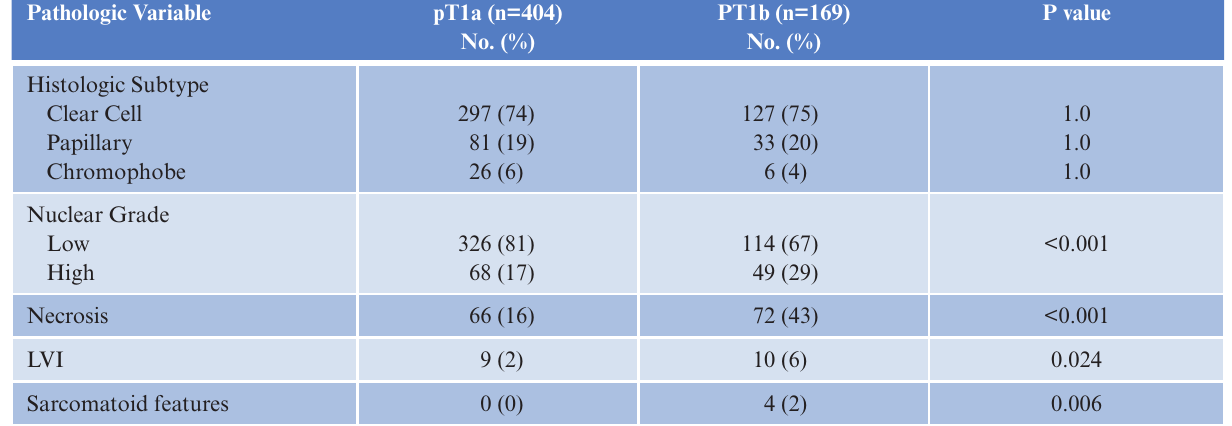
Table 2: Pathologic characteristics of 573 pT1 tumors stratified by size (0–4cm vs. 4–7cm) Pathologic Variable